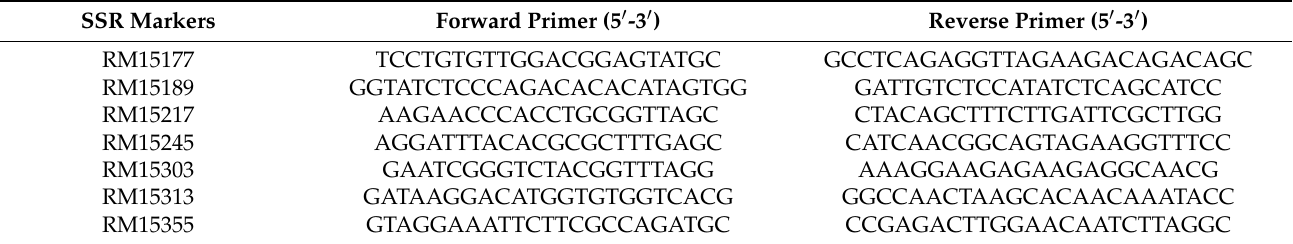
Table 1. Primer sequences of SSR markers used in the mapping of ygl9311